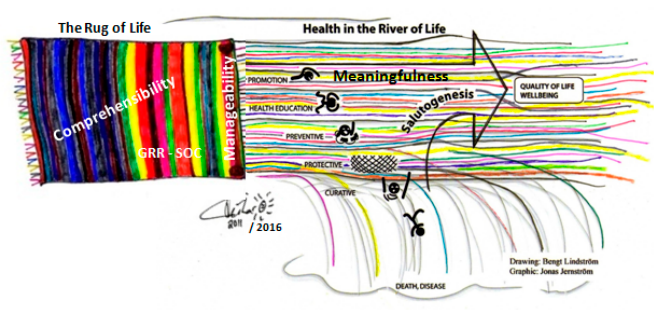
Figure 1. “The Rug of Life” combined with “Health in the River of